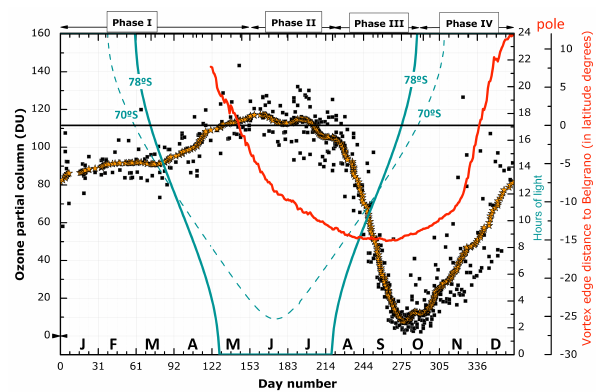
Fig. 3. Seasonal evolution of the 1999–2011 mean ozone in the layer 15–21km (30-day running mean as orange stars). Individual data Figure 3. Seasonal evolution of the 1999-2011 mean ozone in the layer 15-21 km (30-points 3 from ozonesondes for 13yr are shown in black squares. Daily mean running mean as orange stars). Individual data from ozonesondes for 13 years are shown in 4 distance from the vortex edge to Belgrano in terms of equivalent black squares. Daily mean distance from the vortex edge to Belgrano in terms of equivalent 5 latitude computed for the same period (red solid line). Negative val- latitude computed for the same period (red solid line). Negative values means Belgrano is 6 ues mean that Belgrano is inside the vortex. Hours of light at 78 and inside the vortex. Hours of light at 78ºS and 70ºS in the stratosphere (25 km) are represented 7 70 ◦ S in the stratosphere (25km) are represented by the dashed blue by dashed blue line and thick blue line respectively. 8 line and thick blue line,